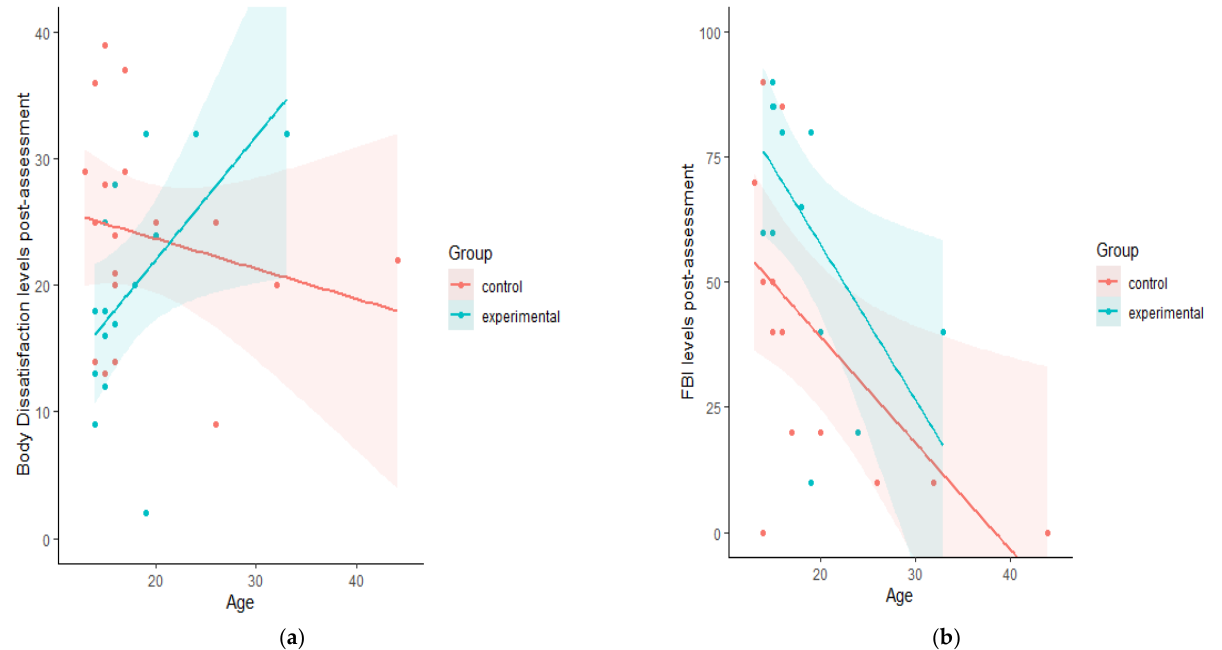
Figure 5. Scatterplots assessing the linear relation between Body Dissatisfaction at the post-assessment, as measured by EDI-3, and age ( a ). And the relation between Full-Body Illusion (FBI) levels at the post-assessment and age ( b ).